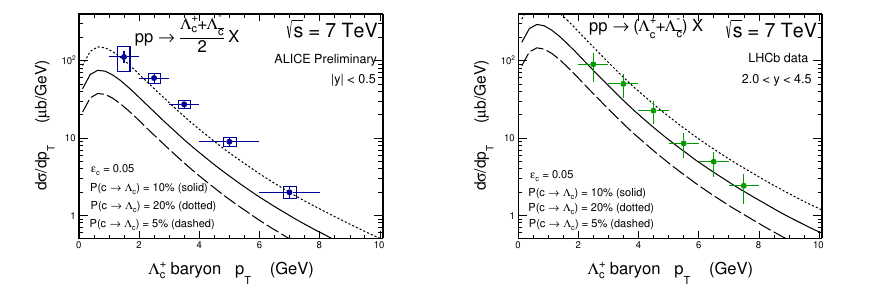
√ s = 7 TeV for ALICE (left panel)